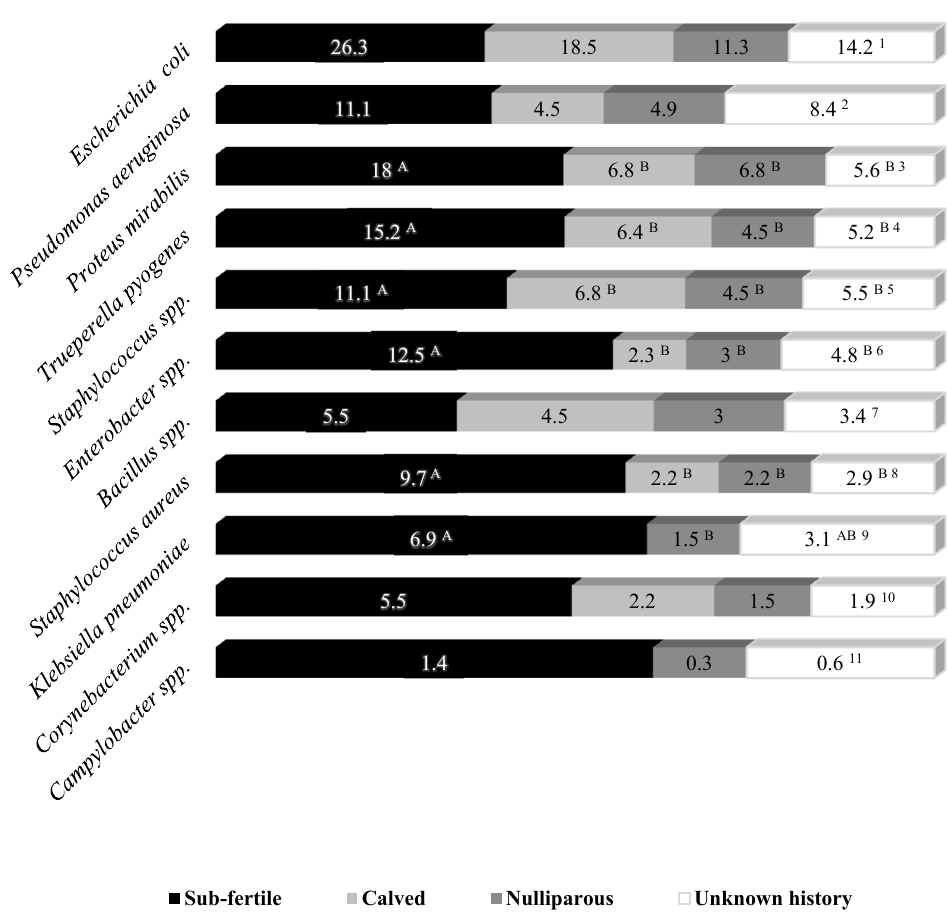
Figure 2. Comparative prevalence of major uterine bacterial isolates in subfertile camels, calved camels, nulliparous and those with unknown reproductive history. Figures represent percentage of isolates in each category (isolate/total number of camels in the same category). Different capital superscripts indicate significant differences in the frequency distribution among the four groups ( p < 0.05). (1) p = 0.120; (2) p = 0.224; (3) p < 0.008; (4) p < 0.031; (5) p = 0.217; (6) p = 0.051; (7) p = 0.767; (8) p < 0.024; (9) p = 0.029; (10) p < 0.089; (11) p <